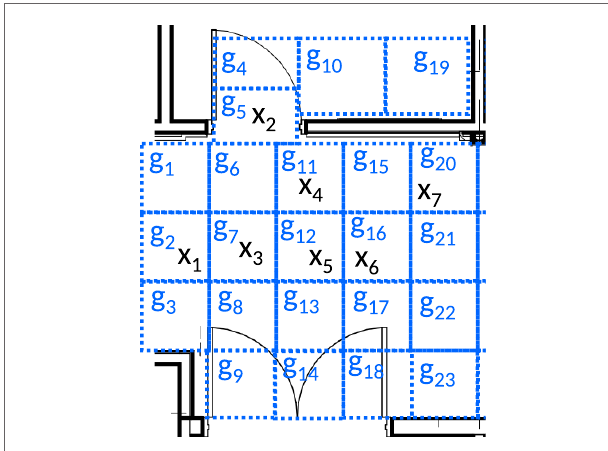
FIGURE 3 | Example portion of a building floor plan partitioned into grid cells labeled g 1 , g 2 , ::: , g 23 . The symbols x 1 , x 2 , ::: , x 7 mark the reported locations of detected footsteps.